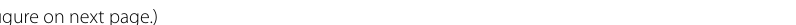
figure on next Fig. 2 Topography in and around the Iheya–Izena islands. A Topographic anaglyph with contour lines. Black contour lines on anaglyph indicate 50 m, 80 m and 120 m, respectively. B Distribution of submarine terraces and active faults. Arrows and red dashed lines indicate − − − active fault scarps and the base of convex slopes deformed according to the basin surface, respectively. Black dashed lines show the locations of the topographical profiles shown in Figs. 4a and 5a. WSIS: west slope of Iheya–Izena islands named in this